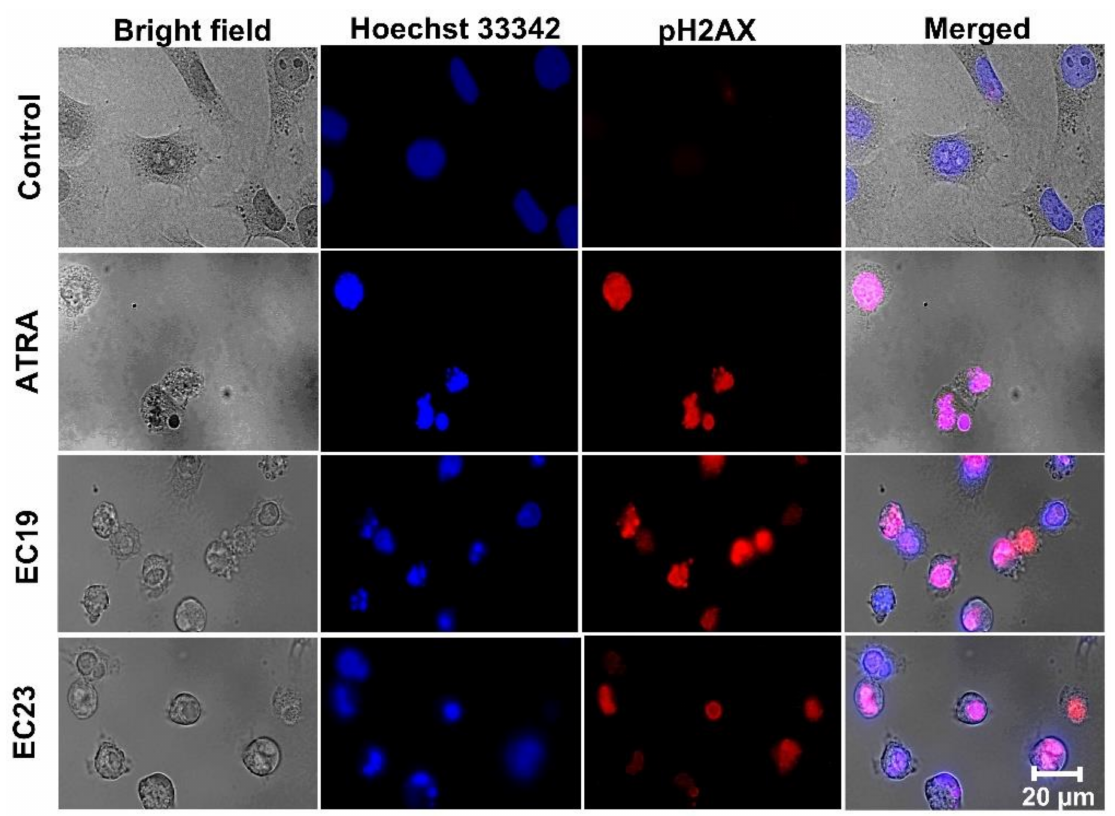
Figure 4. Imaging and analysis of genotoxicity induced by EC-synthetic retinoids in Caco-2 cells using the HCS DNA Damage Kit. Caco-2 cells were treated with IC 50 concentration of EC-synthetic retinoids as well as ATRA compared to the negative control (0.1%DMSO) for 24 h at 37 ◦ C, 5% CO 2 . Using the Carl Zeiss LSM 710 confocal microscope (63 × magnification; at 20 µ m scale), these images were captured to clearly indicate that many γ -H2AX foci were observed in the Caco-2 cells treated with all retinoids with preference to EC19, but not with negative control. Hoechst 33,342 was used to map